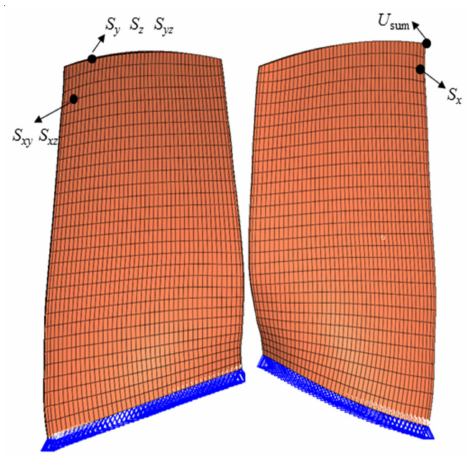
Figure 5. FE model of the rotor blade.